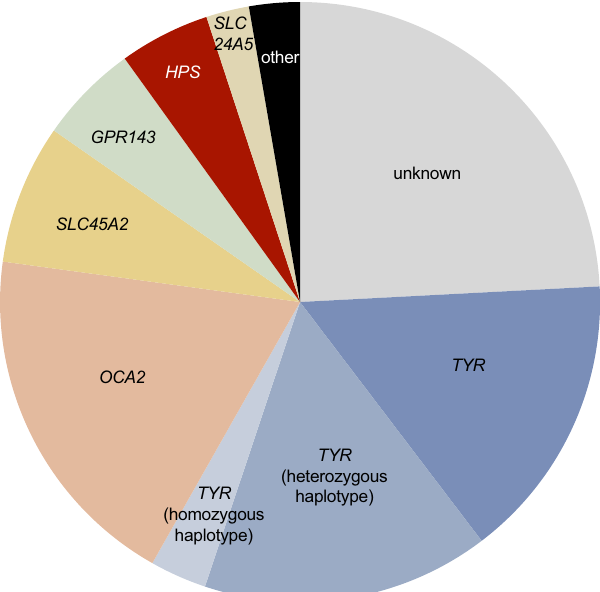
Table 1 Contribution of different classes of albinism-related variants to disease